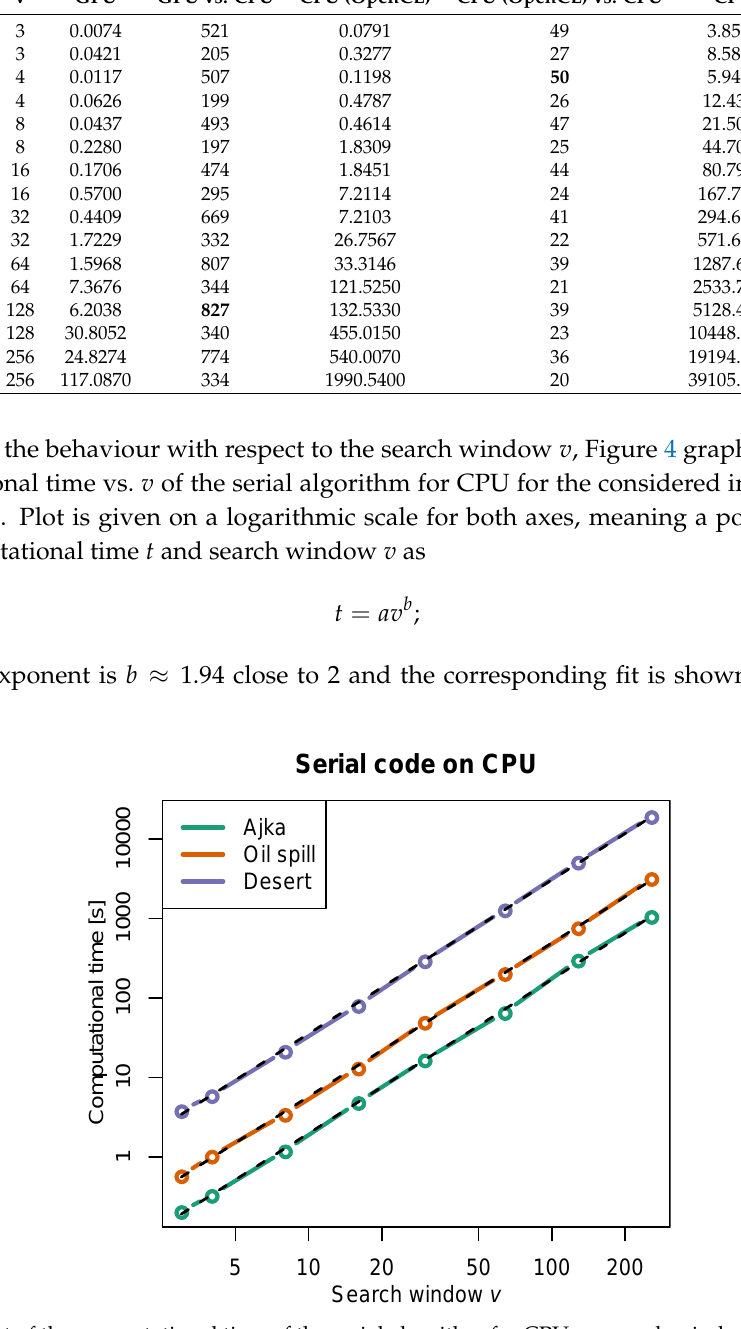
Figure 4. Plot of the computational time of the serial algorithm for CPU vs. search window v (similarity window d = 1). Curves refer to the Ajka, Oil Spill and Desert images. The fit by Equation (4) is also shown as a dashed